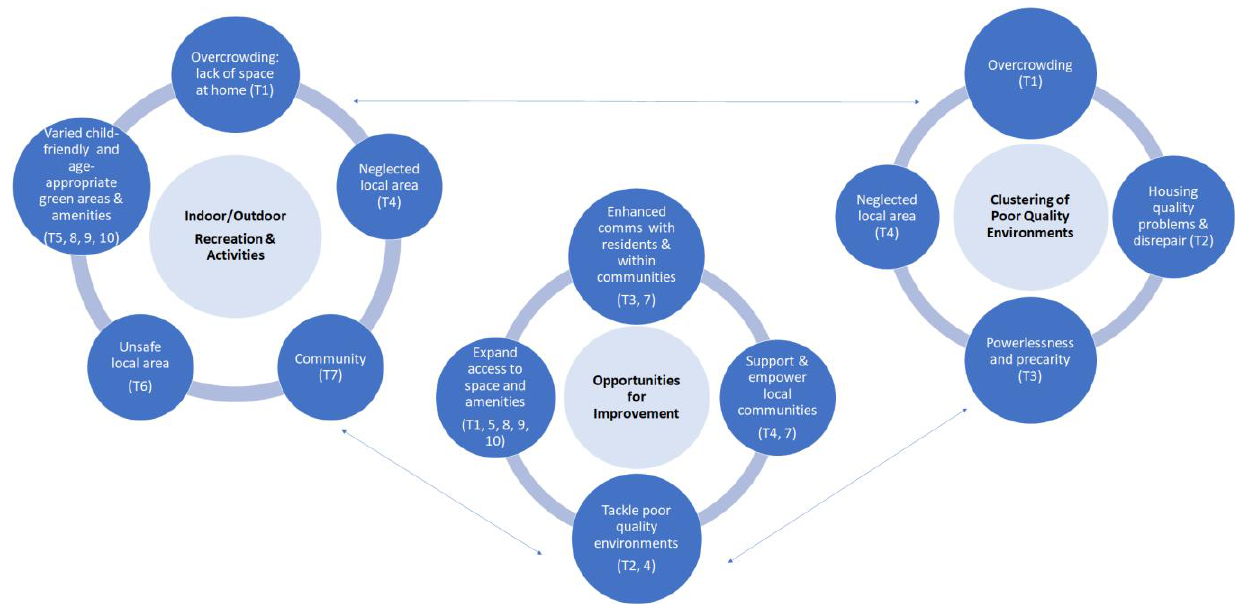
Figure 6. Thematic map illustrating the relationships across the ten themes via three main thematic clusters.